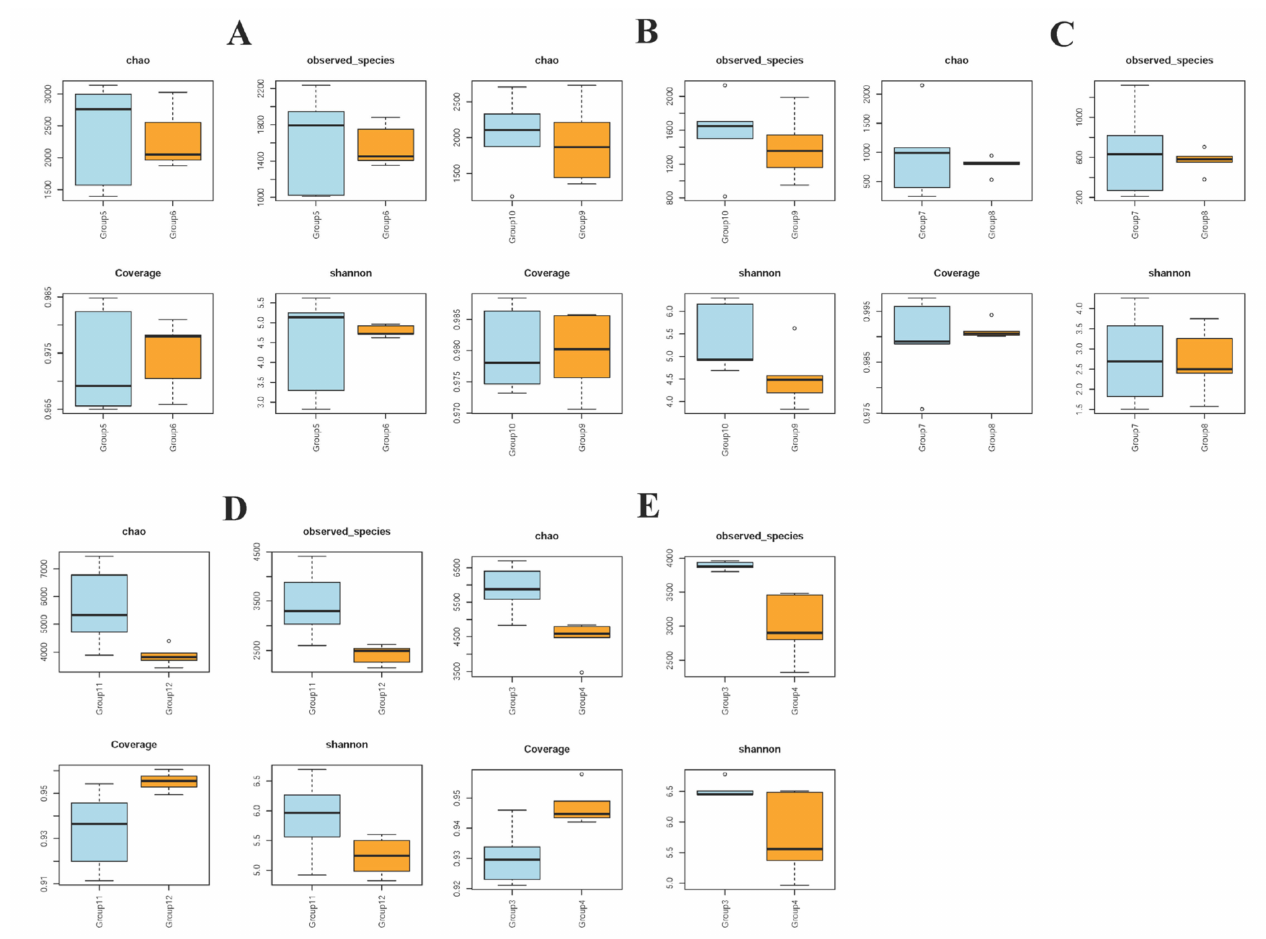
Figure 2. Alpha diversity indices on the effects of colistin on gastrointestinal tract microbiome change in piglets. ( A ) Stomach (Group 6, Group 5); ( B ) duodenum (Group 10, Group 9); ( C ) jejunum (Group 8, Group 7); ( D ) cecum (Group 12, Group 11); ( E ) feces (Group 4, Group 3); colistin treated group: Group 6, group 10, group 8, group 12, and group 4; control group: Group 5, group 9, group 7, group 11, and group